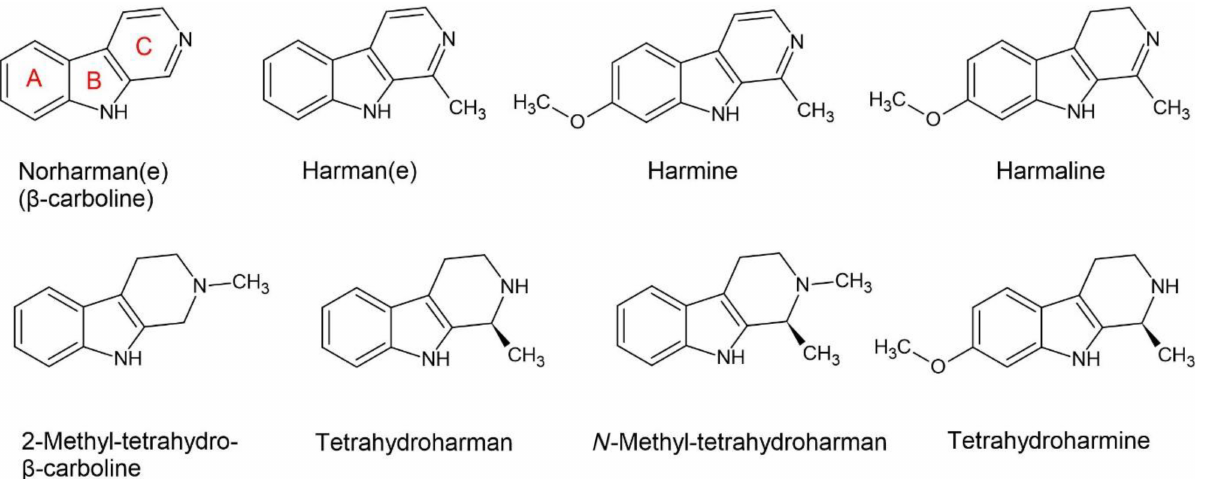
Figure 3. The types of β -carboline alkaloids identified in Acacia and its sister genera, with the